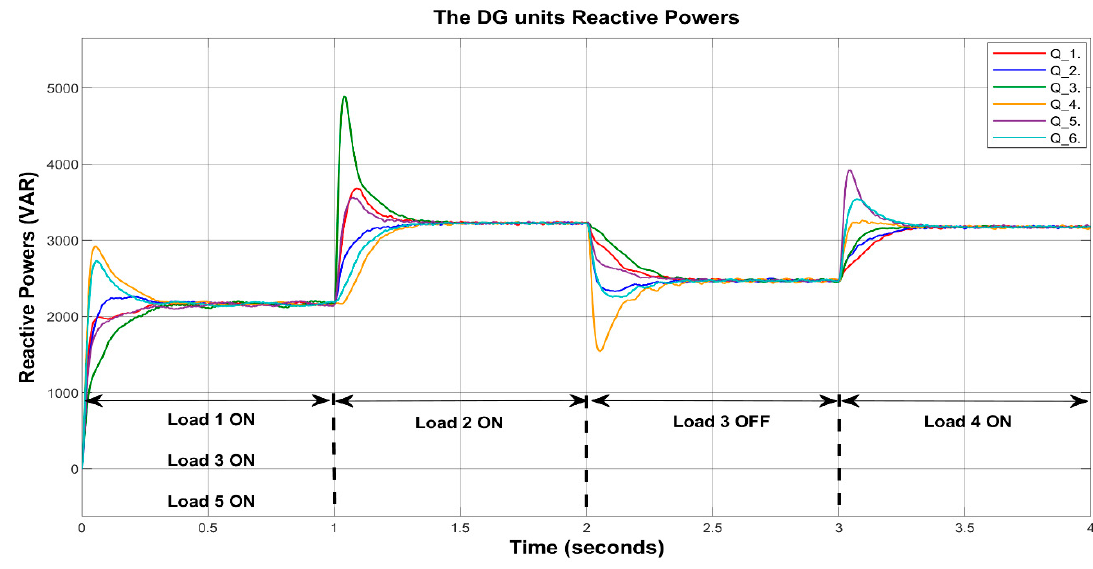
Figure 18. The DG units’ reactive powers for Case 3.